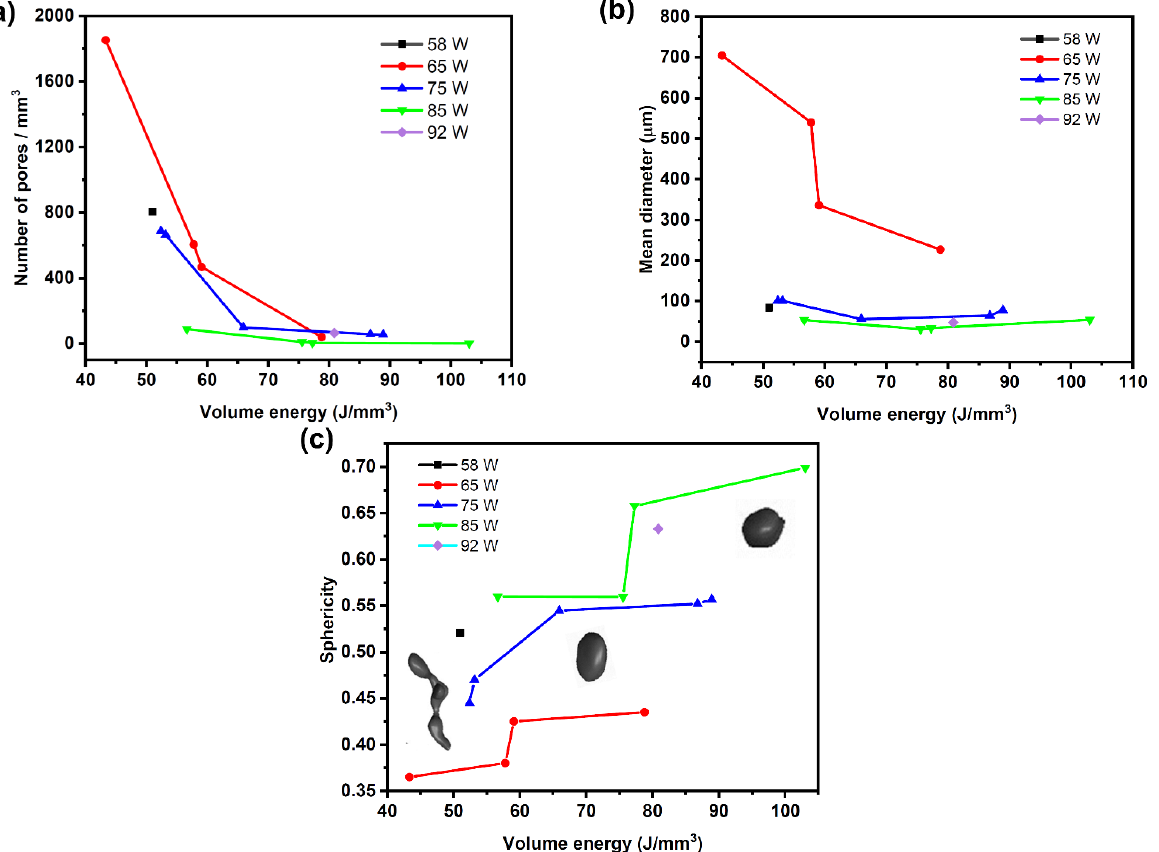
Figure 5. Pore properties change with power and volume energy: ( a ) number of pores/mm 3 , ( b ) mean diameter and ( c ) sphericity. The three inserts in ( c ) are representative pores showing increasing sphericity.